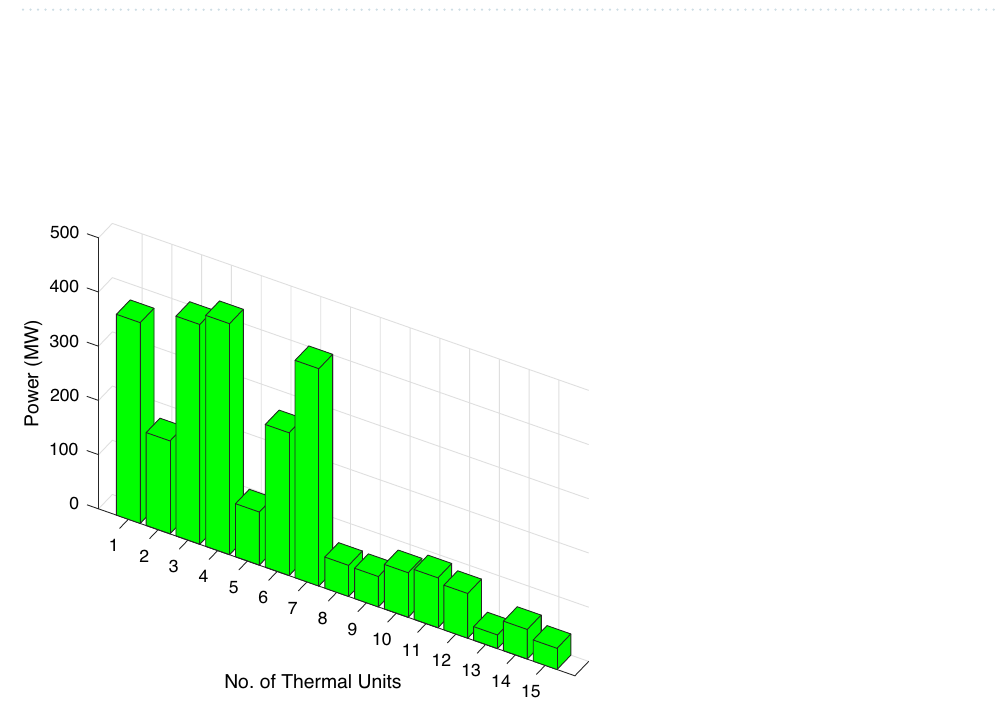
Table 11. Performance analysis of ABWO comparing other approaches case study-IV. Significant values are in bold.